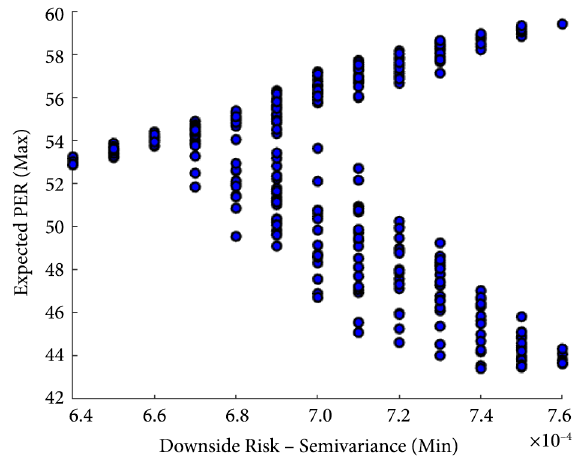
Figure 5. Downside Risk vs.